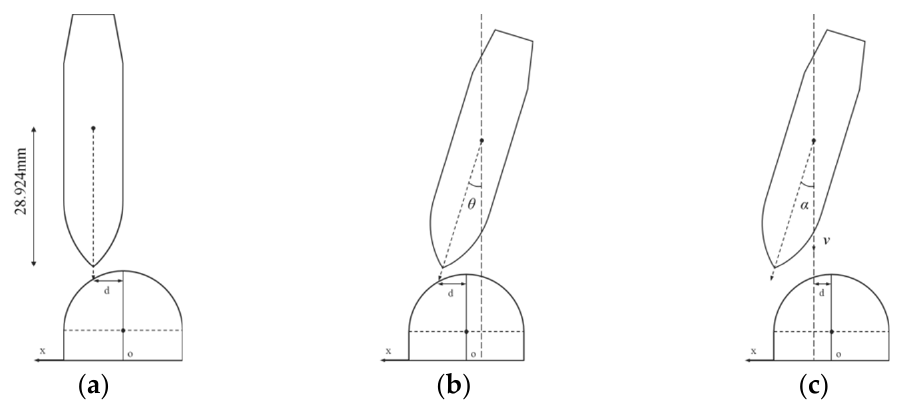
Figure 4. Schematic diagram of impact points in the case of normal penetration, oblique angle, and angle of attack. ( a ) Impact point in the case of normal penetration; ( b ) impact point in the case of oblique angle θ ; ( c ) impact point in the case of angle of attack α .